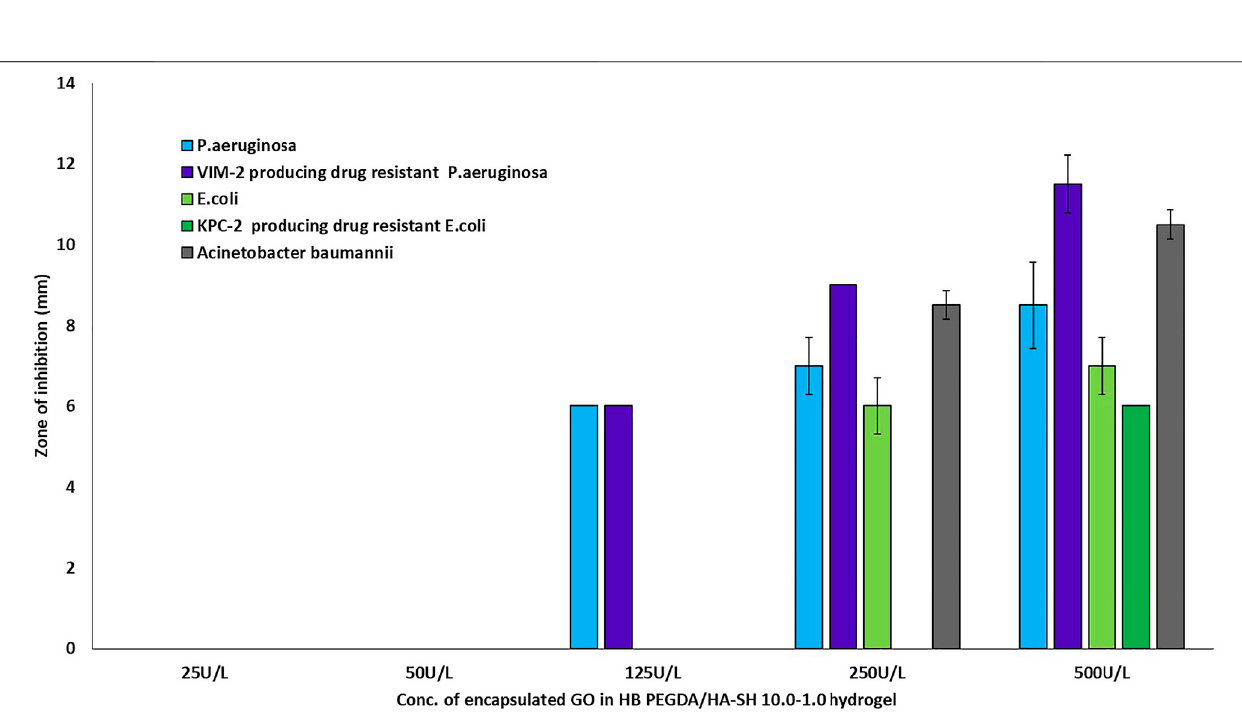
Frontiers in Bioengineering and Biotechnology |